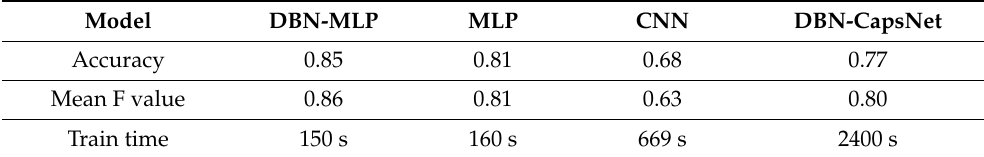
Table 3. Comparison of evaluation parameters of three